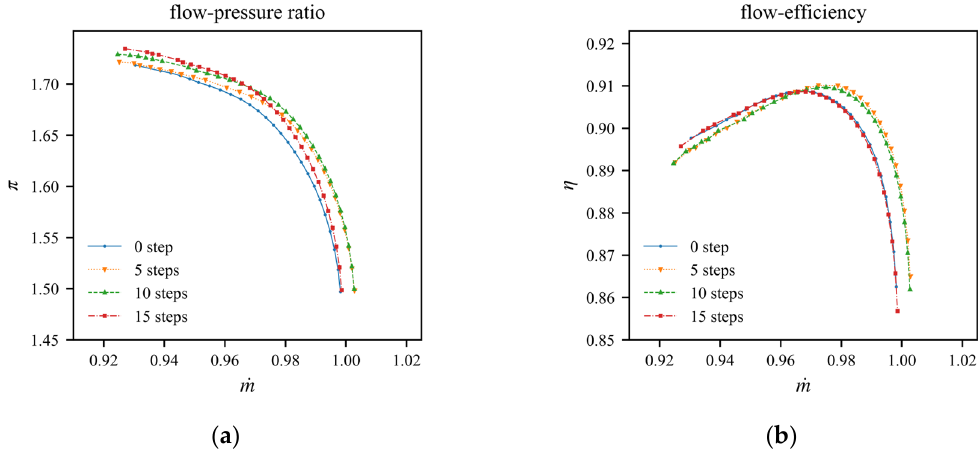
Figure 10. Operating characteristic variation in the rotors after different steps (from previous work). ( a ) Flow-pressure ratio. ( b ) Flow efficiency.